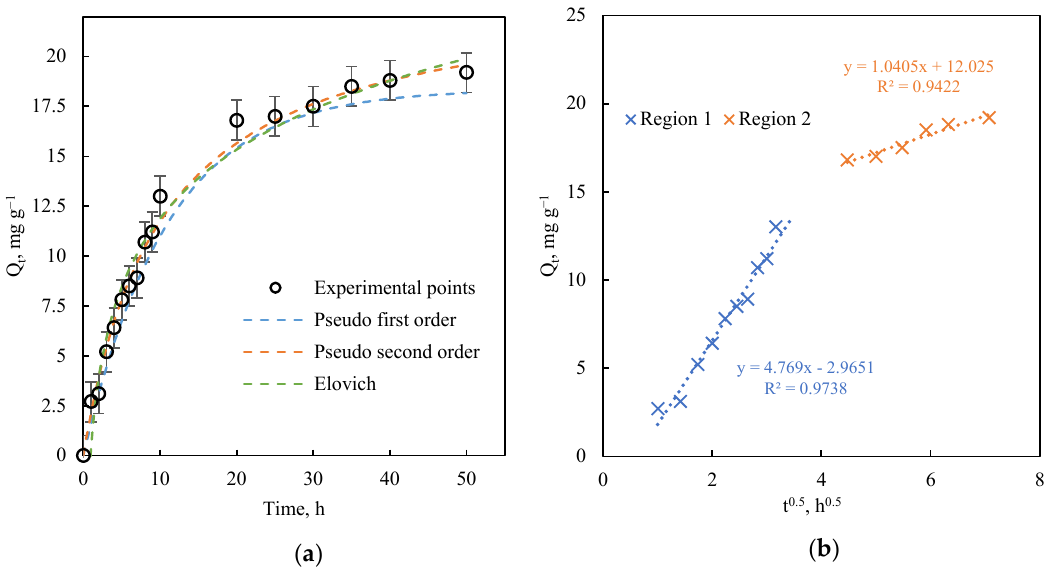
Figure 2. ( a ): Experimental kinetic curve and fitted kinetic models and ( b ): intraparticle diffusion model regression (C 0 = 25 mg L −1 , 0.1 g of adsorbent, V = 0.1 L at 25 °C, pH = 6).